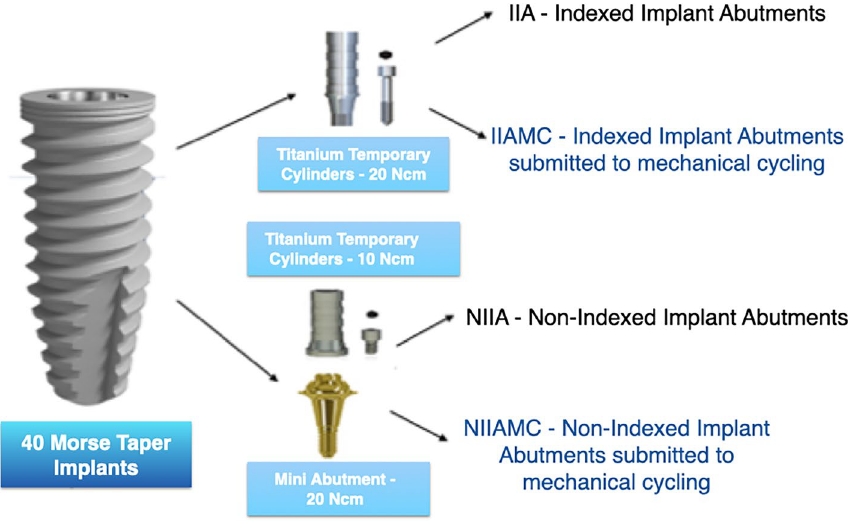
Figure 1. Representative scheme of the indexed Morse taper implant, with the respective indexed and non- indexed abutments, on which the 40 sets of implants and prosthetic abutments for groups IIA, NIIA, IIAMC and NIIAMC were